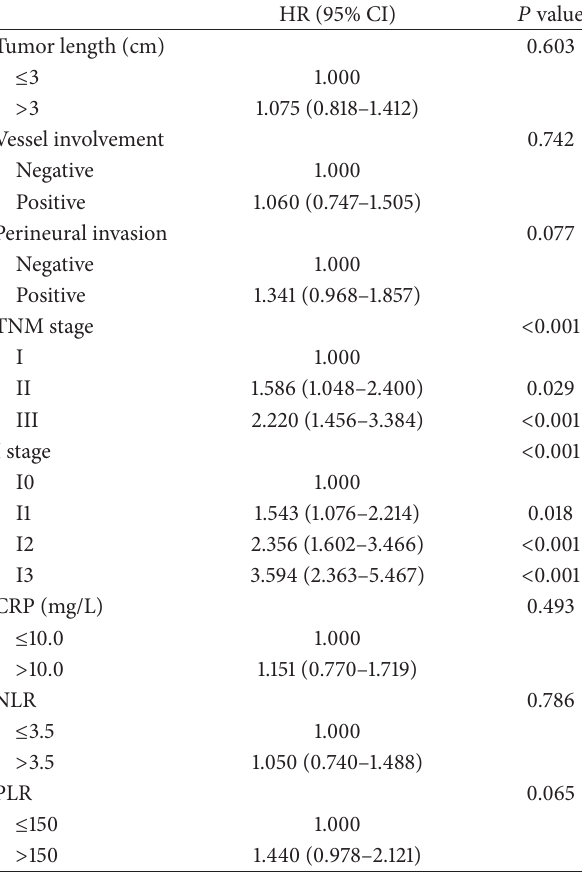
Table 4: Multivariate analyses for patients with